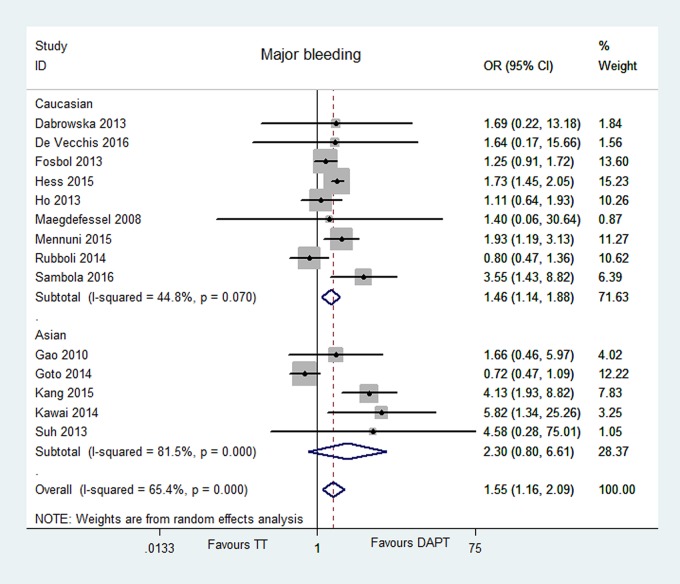
Forest plot of subgroup analysis with Caucasian and Asian in major bleeding.